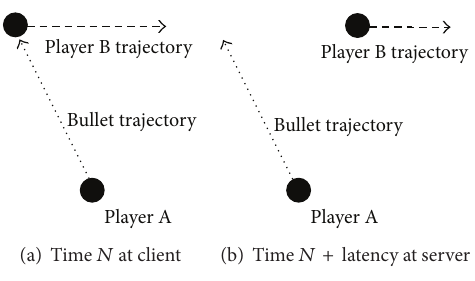
Figure 1: Inconsistency without time